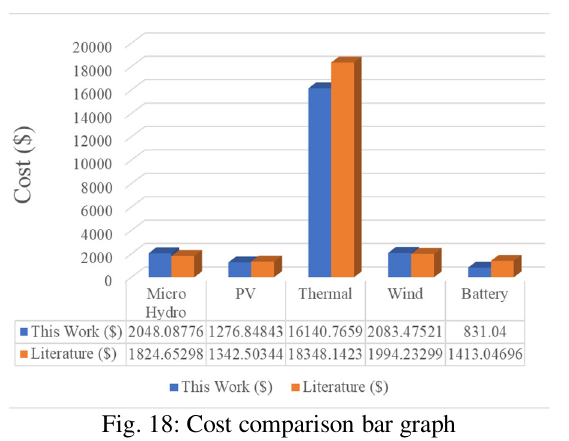
Fig. 18: Cost comparison bar graph